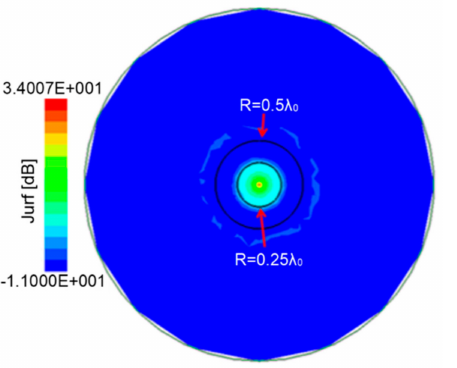
Figure 1. The current distribution for monopole antenna centered on the ground plane.